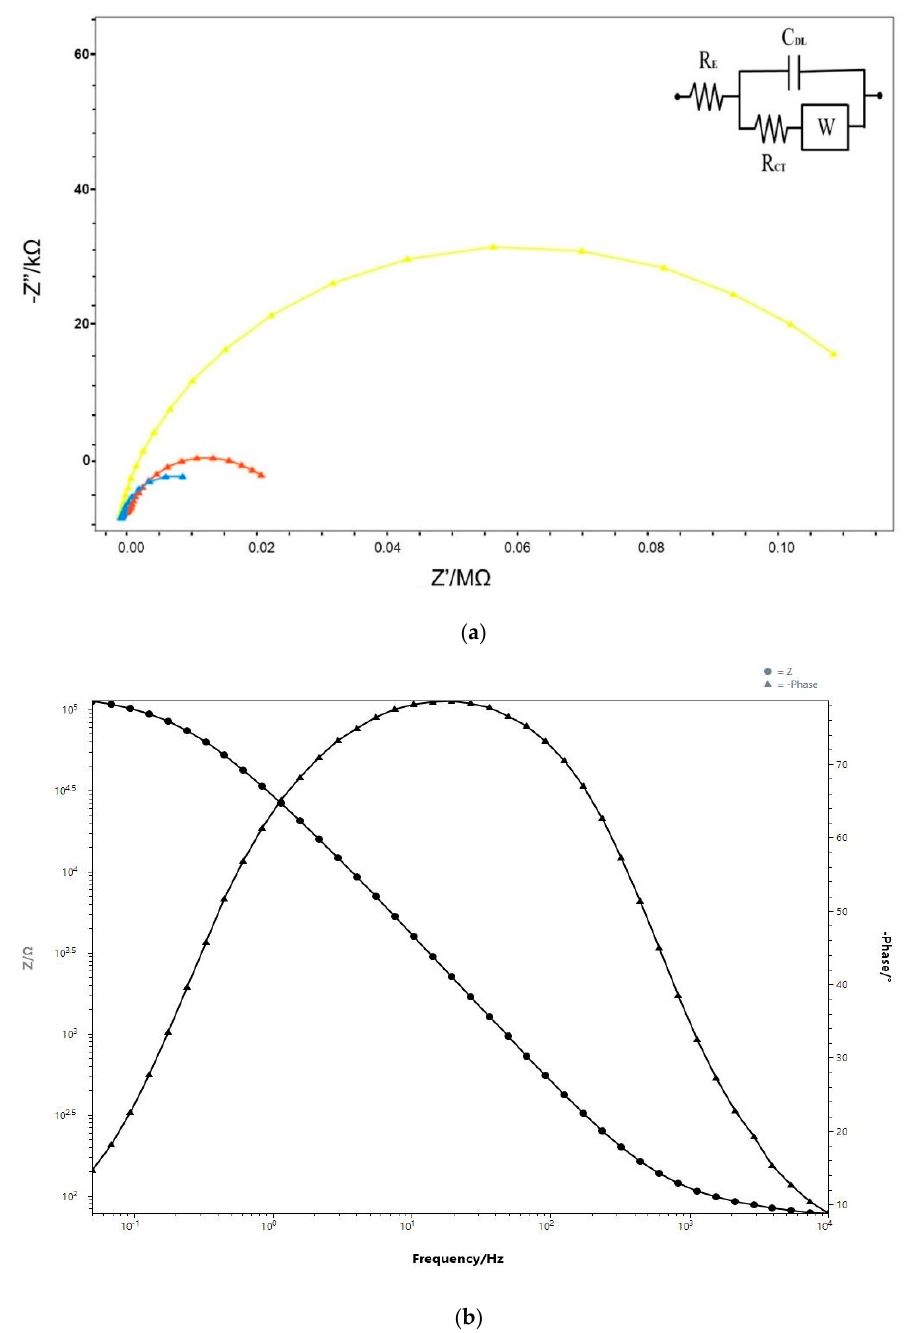
Figure 2. Characterization of electrodes. ( a ) Nyquist plots of Faradaic EIS. GO (red), rGO (blue) and FA-saturated rGO (yellow) electrodes. ( b ) Bode plot of Faradaic EIS obtained from the FA-saturated rGO electrode.